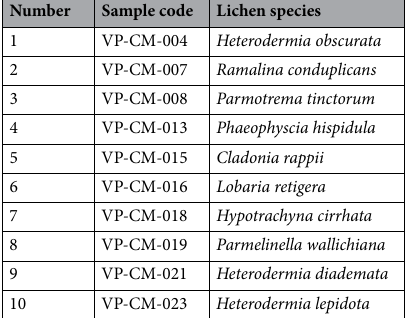
Table 3. The lichens used in this